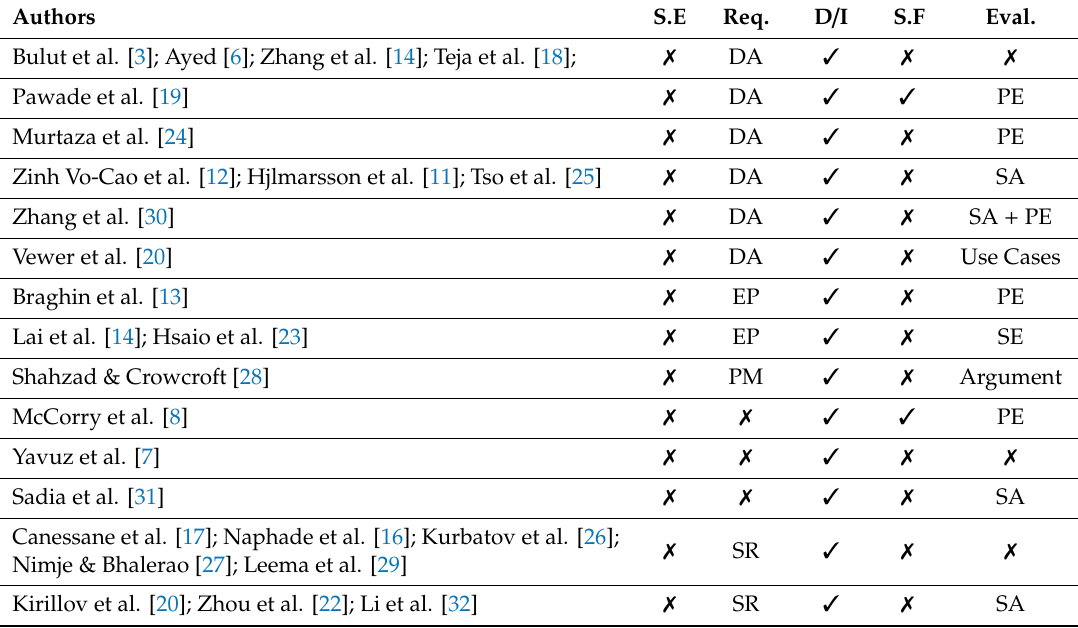
Table 1. Summary of approaches used for blockchain e-voting